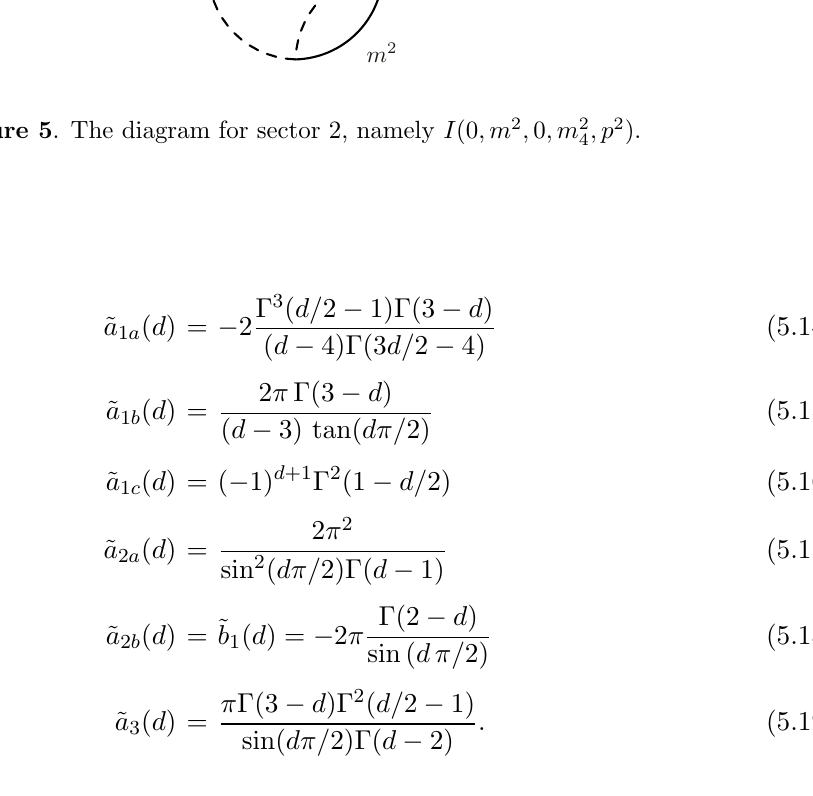
Figure 5 . The diagram for sector 2, namely I (0 ; m 2 ; 0 ; m 2